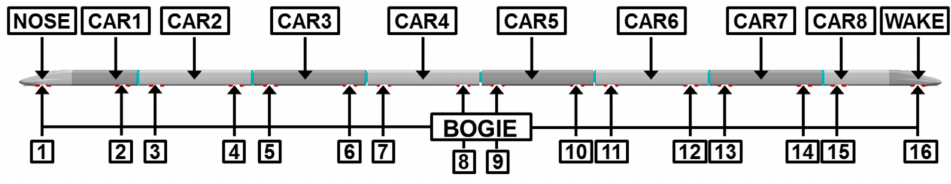
Figure 6. Geometry of